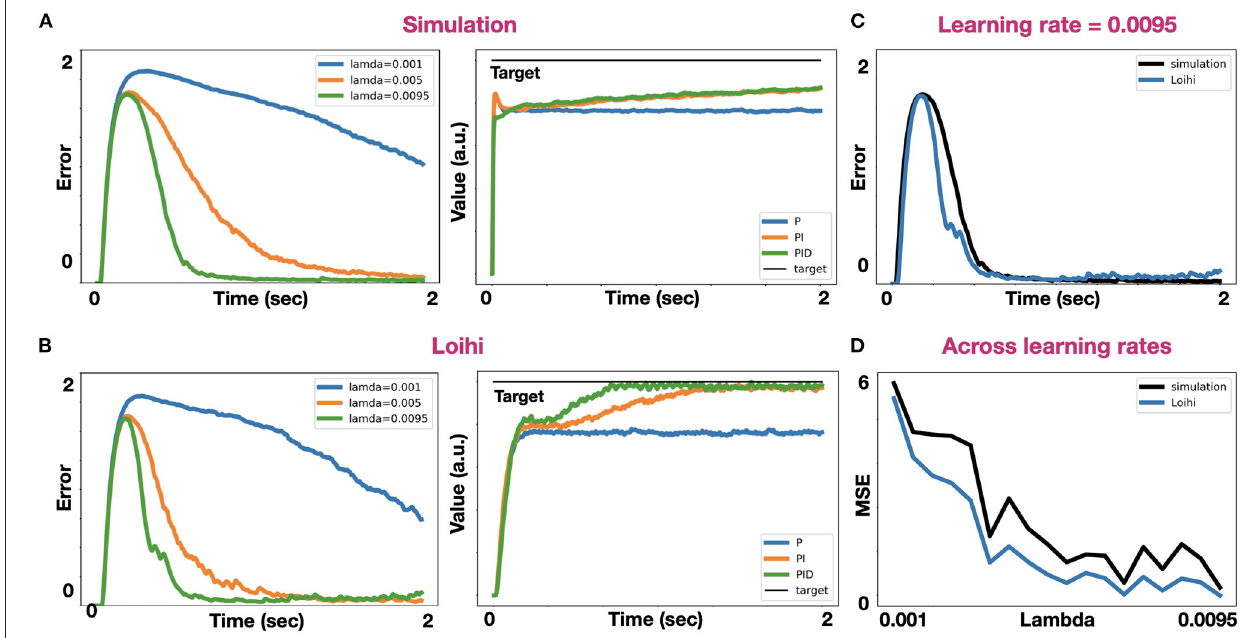
FIGURE 6 | Comparative analysis between simulation and the Loihi. (A) IK error trace in simulation with three different learning rates: 0.001, 0.005, and 0.0095 (left). PID-control in a simulation where k p = 1, k i = 0.1, k d = 0.35, and τ = 0.1 (right); (B) IK error trace (left) and PID control (right) on the Loihi, with the same parameters used in simulation; (C) Super imposed IK error traces on simulation and the Loihi with a learning rate of 0.0095; (D) Mean squared error for IK across different learning rates on both simulation and the